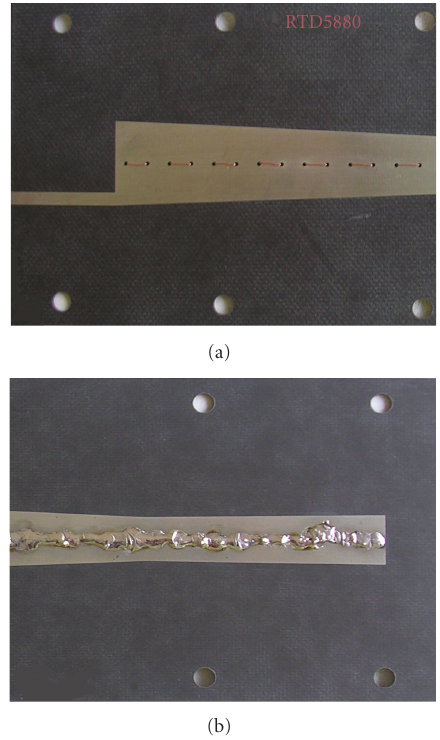
Figure 4: (a) A prototype of tapered LWA with wires in the holes. (b) The soldering made in the centerline of the antenna to cover the wires in the